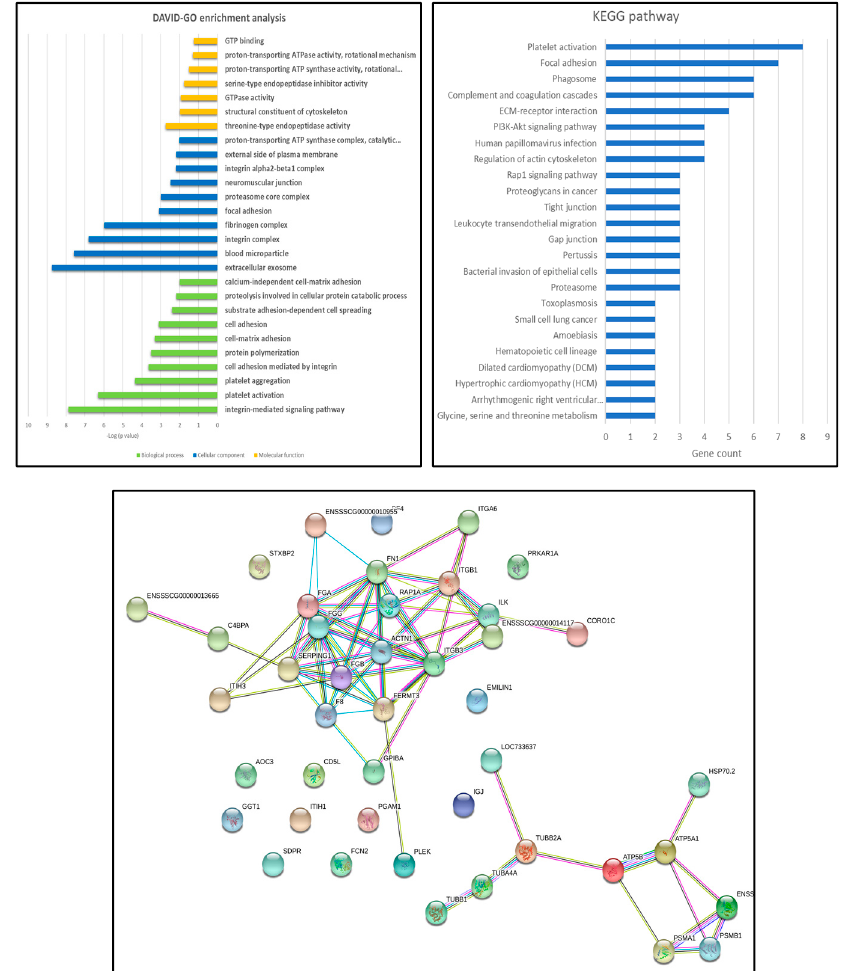
Figure 6. Gene ontology analyses of Benin Δ MGF EV-enriched fractions, where differentially expressed swine proteins were classified according to the biological process, cellular component or molecular function, as well as a string pathway analysis for all proteins differentially expressed in Benin Δ MGF-infected animals.